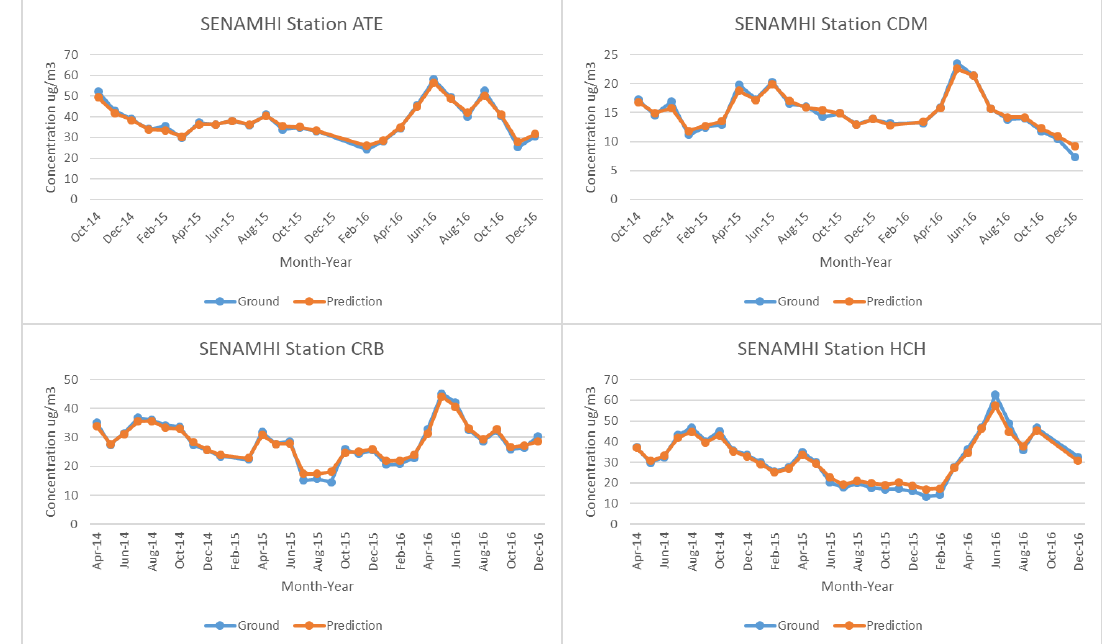
Figure 4. Importance of each variable in the random forest model by percent increase mean square prediction error (MSE).